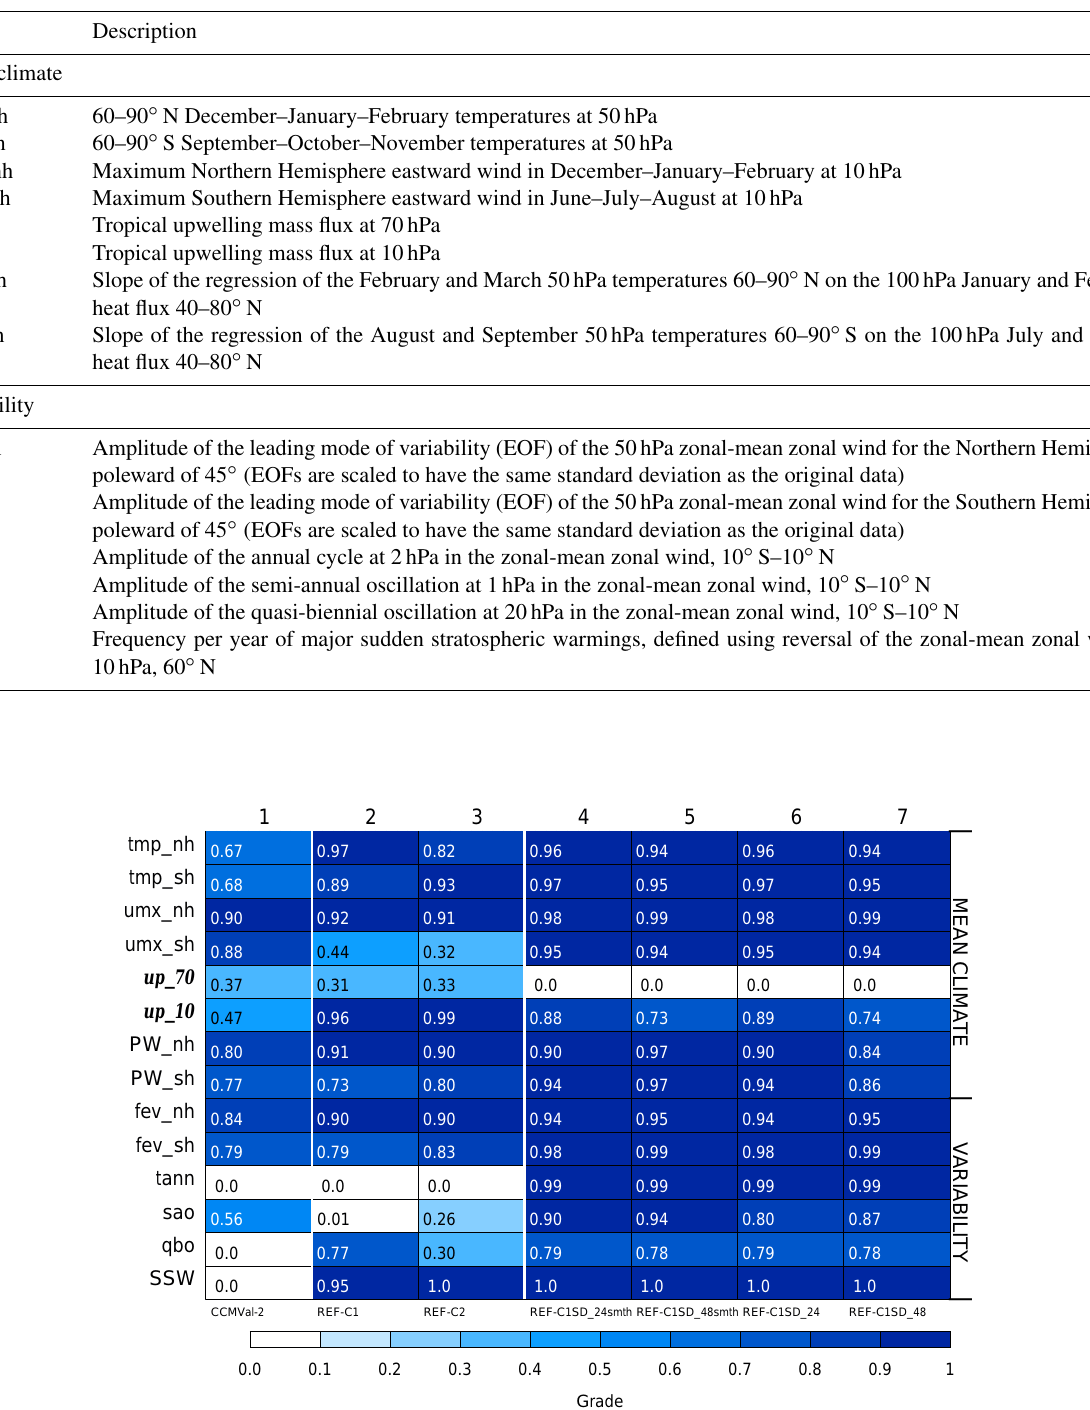
Figure 1. Metrics of dynamical fields and processes (see Table 2). Bold italic font indicates metrics which are not directly constrained in the nudged simulations. Column numbers are printed above each column, and the model simulation is printed below each column. For details of model simulations, see Table 1 (where “24smth” corresponds to “24h, smoothed”,